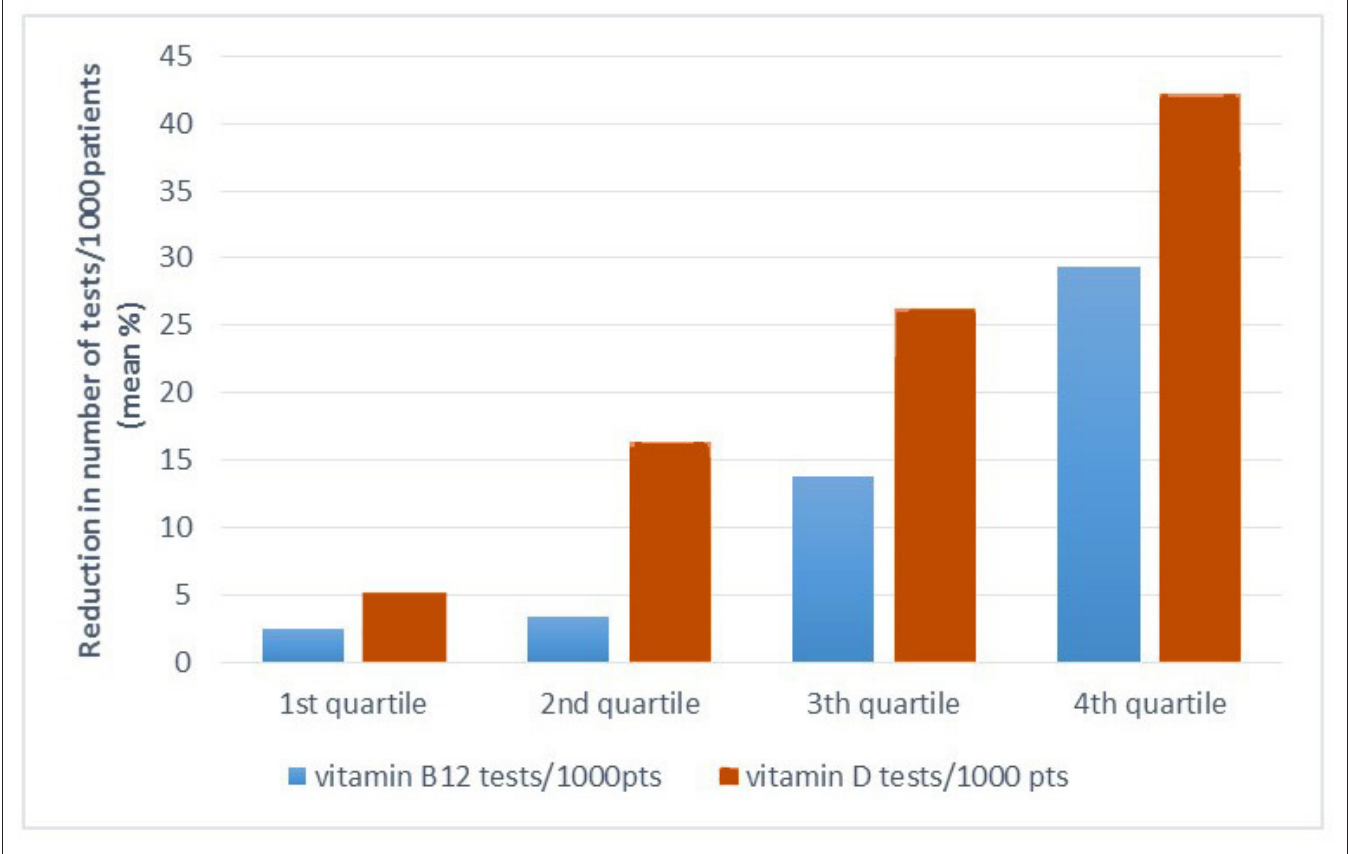
Figure 2 Number of ordered vitamin tests in pre- intervention period (in quartiles) related to reduction in number of ordered tests during intervention period. pts = patients.